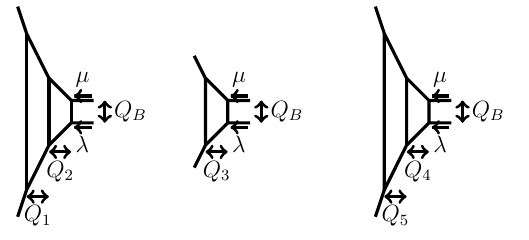
Figure 10 . The assignment of the K(cid:127)ahler parameters to the web in (cid:12)gure 9. We write the three webs separately for